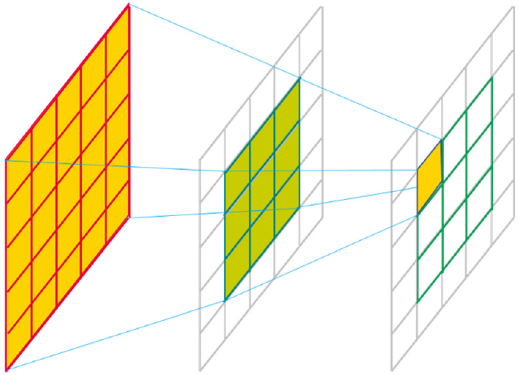
Figure 7. Receptive filed.